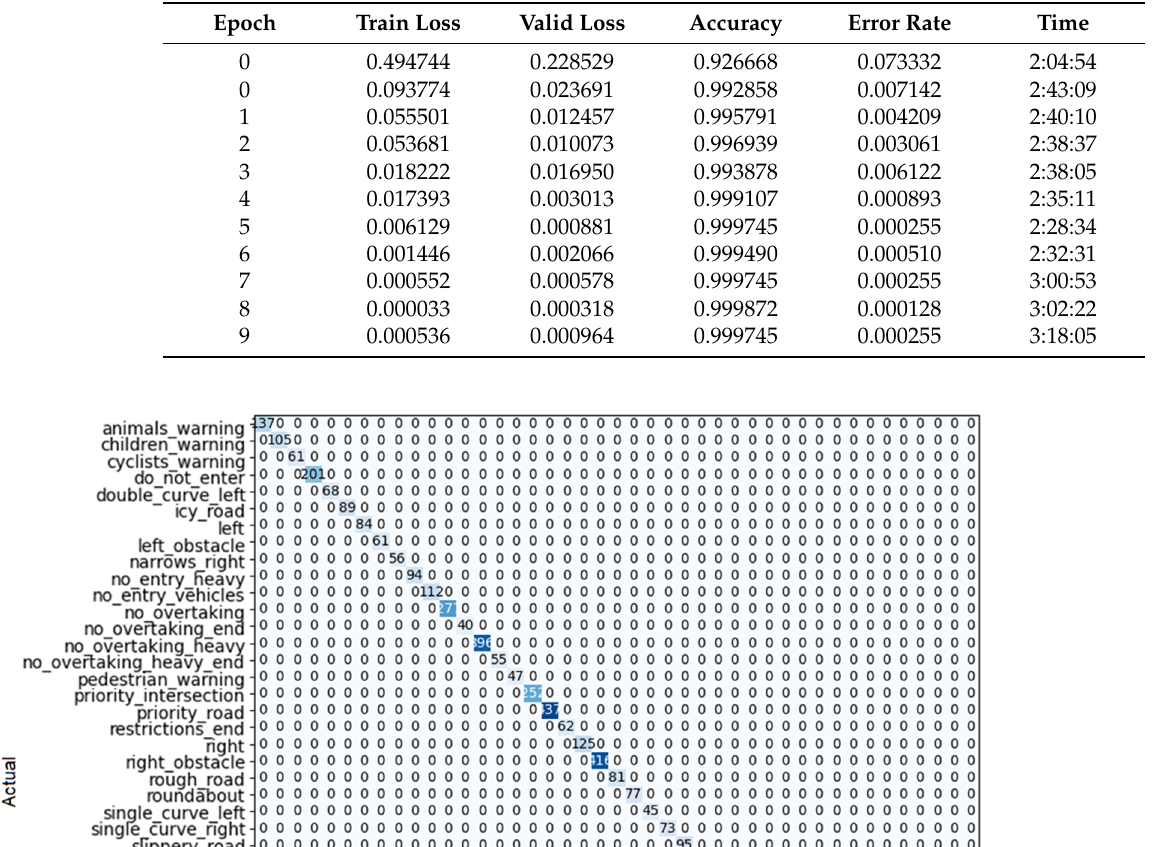
Table 4. Results of the ResNet 50.